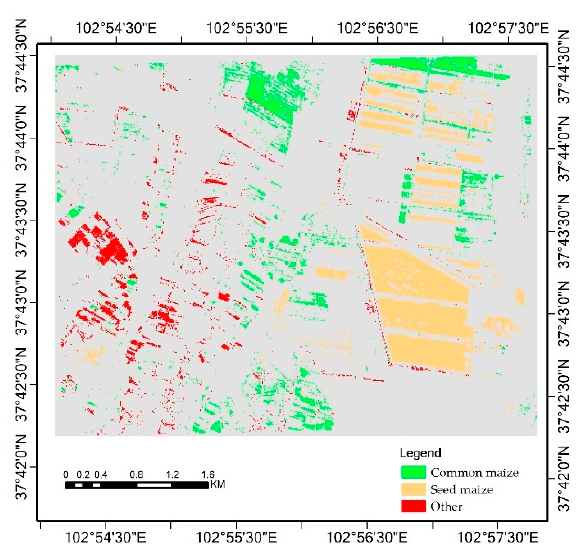
Figure 12. The spatial distribution of the new samples including common maize, seed maize, and other crops, which were generated from historical samples combined with spectral information.